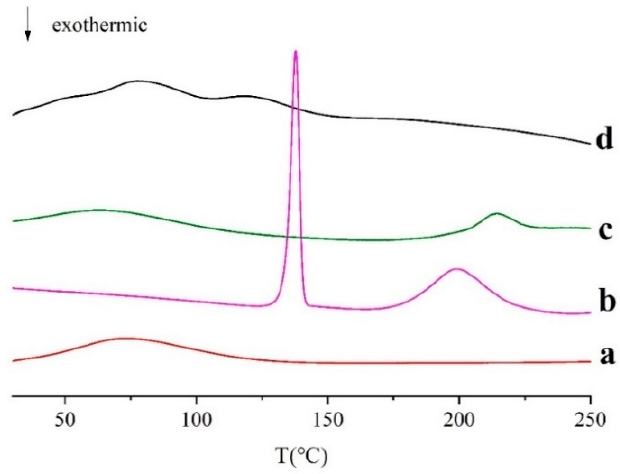
Figure 6. Differential scanning calorimetry (DSC) curves of ( a ) CS; ( b ) Man; ( c ) BSA, ( d ) Man-BSA-CS-NPs.